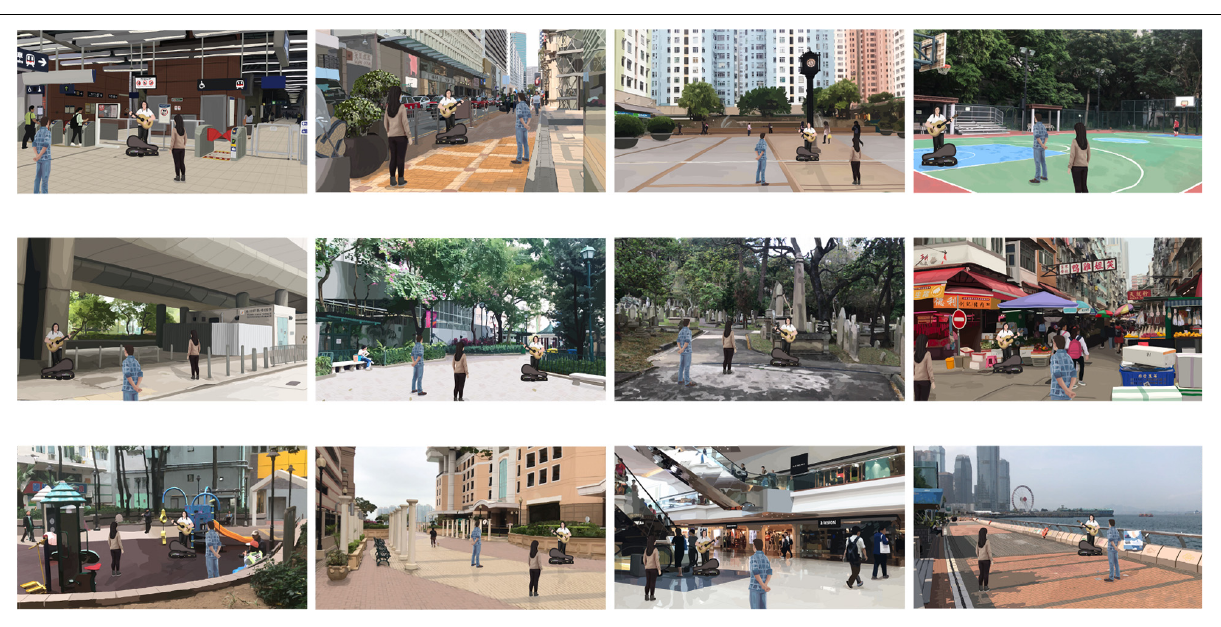
FIGURE 2 | Pictorial stimuli of public spaces with street performance (top row, from left to right, transport facility, street, square, and recreational space; middle row, from left to right, found neighborhood space, park, memorial, and market; and bottom row, from left to right, playground, community open space, indoor marketplace, and